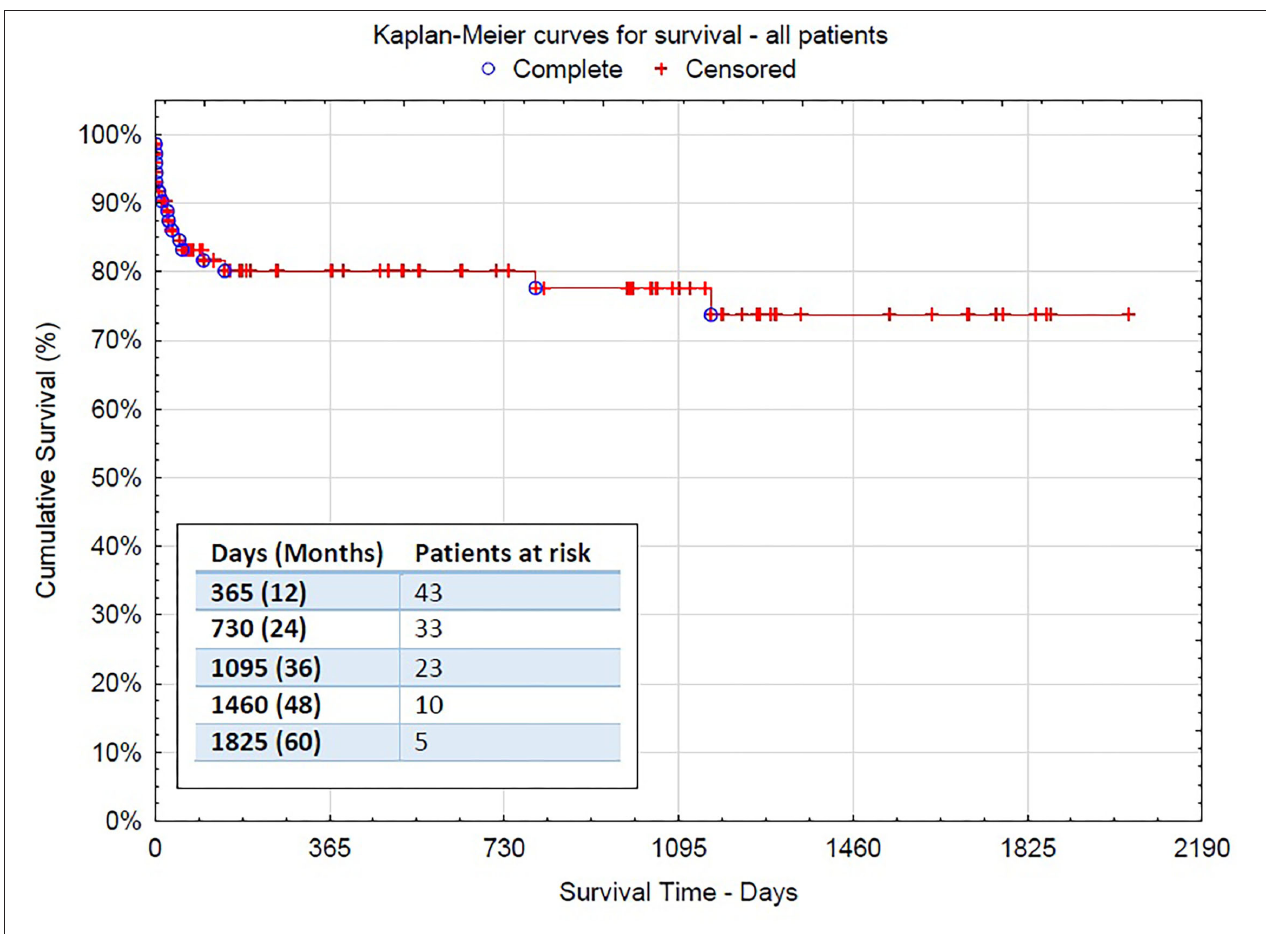
FIGURE 3 | The Kaplan–Meier survival curve for the overall surgical population − 95% confidence interval [ CI ] 1,574.015